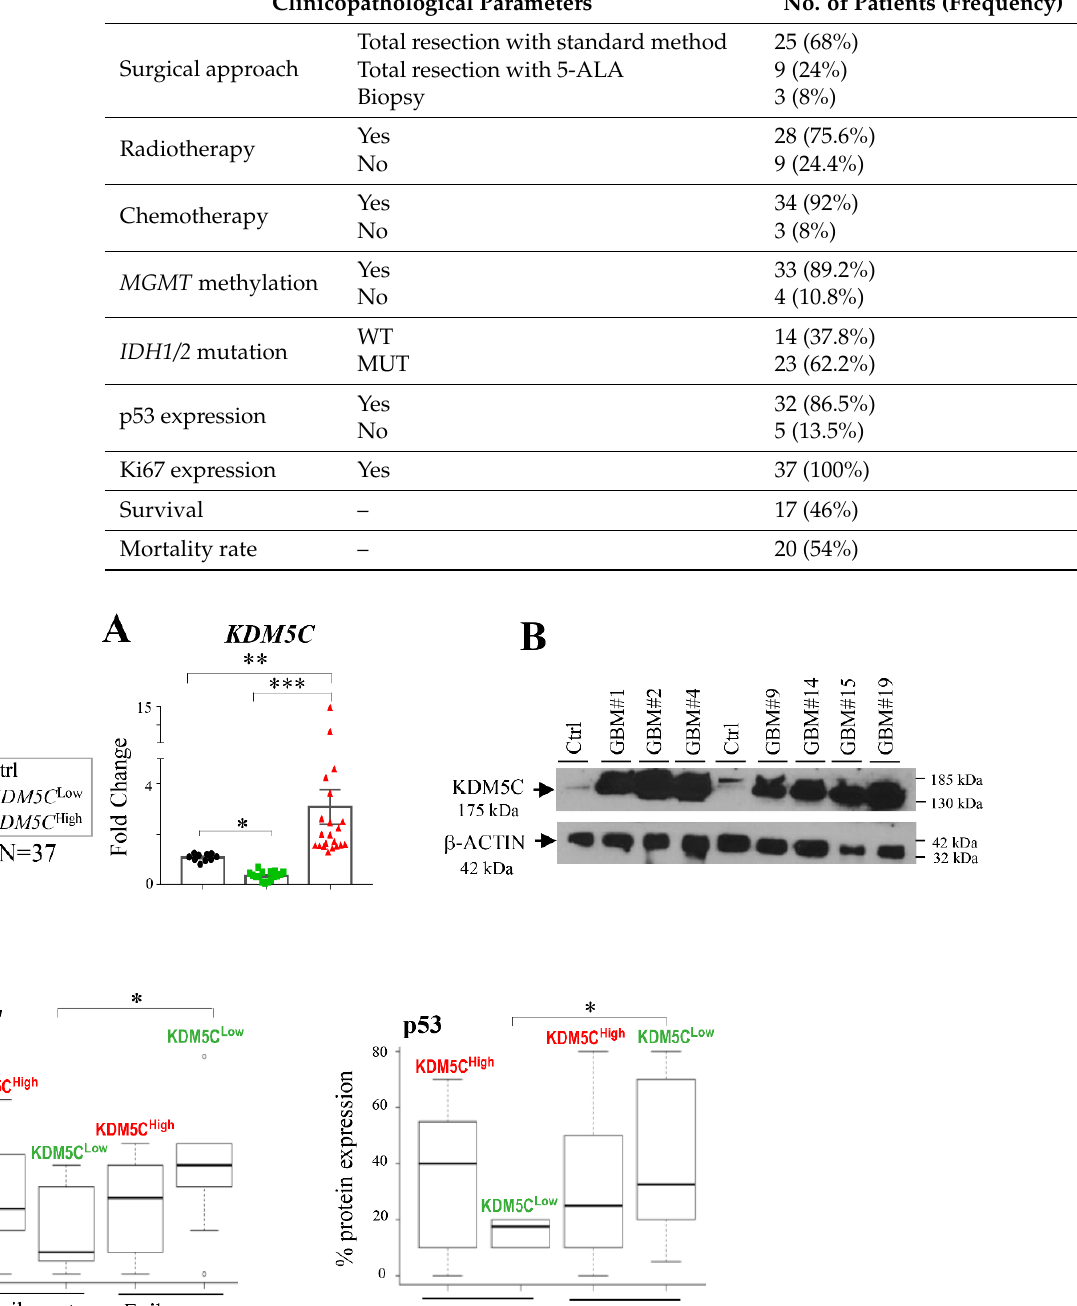
Figure 1. Expression analysis in KDM5C Low and KDM5C High cohorts. ( A ) Analysis of KDM5C ex- pression by real-time PCR (RT-PCR) assay and ( B ) Western blotting. ( C ) Ki67 expression analysis in GBM patients with (Epilepsy+) or without epilepsy (Epilepsy − ), and p53 expression analysis in GBM